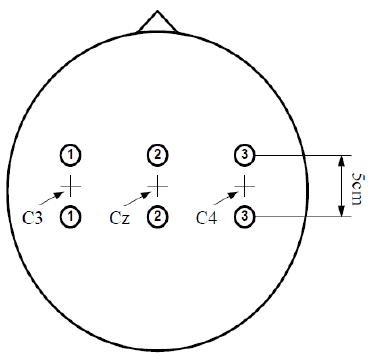
Figure 3. Electrode placement.